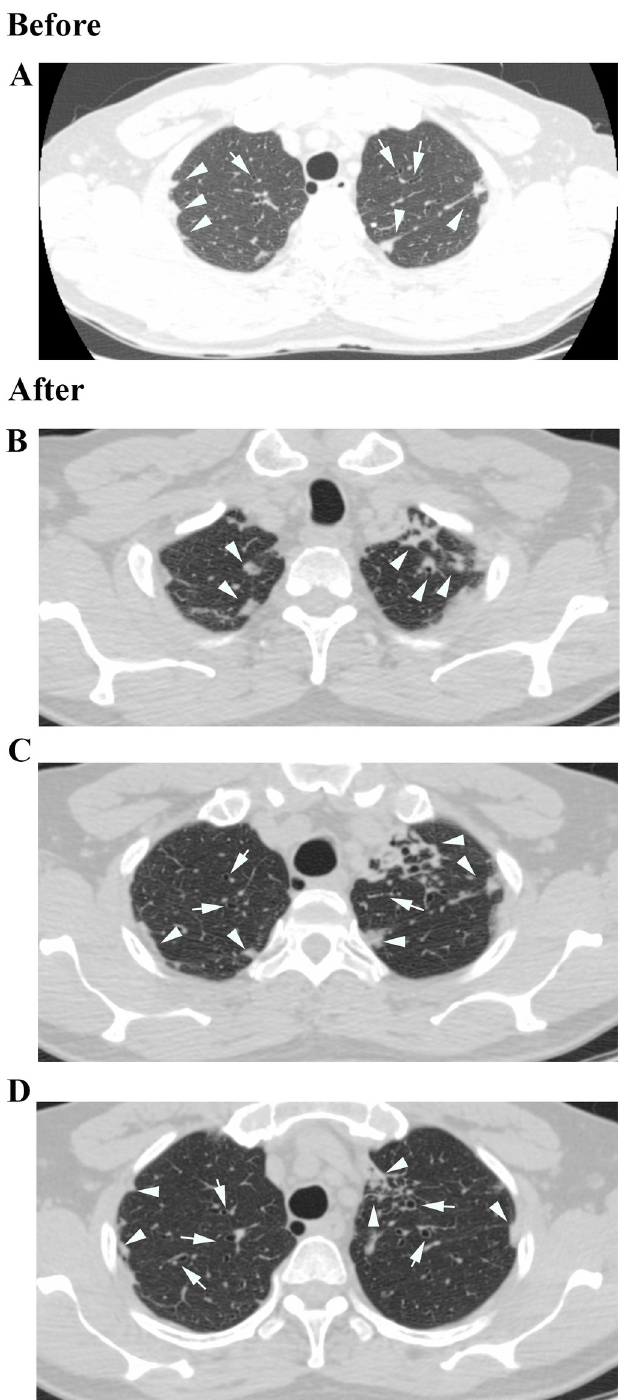
Fig 4. Chest HRCT of a 64-year-old man (2014–2019). (A) Before: Bronchiectasis (Arrows), Centrilobular Nodules (Arrowheads); (B) After: Centrilobular Nodules in a Tree in Bud shape (Arrowheads); (C) After: Bronchiectasis (Arrows) and Centrilobular Nodules (Arrowheads); (D) After: Bronchiectasis (Arrows) and Pleural thickening (Arrowheads).